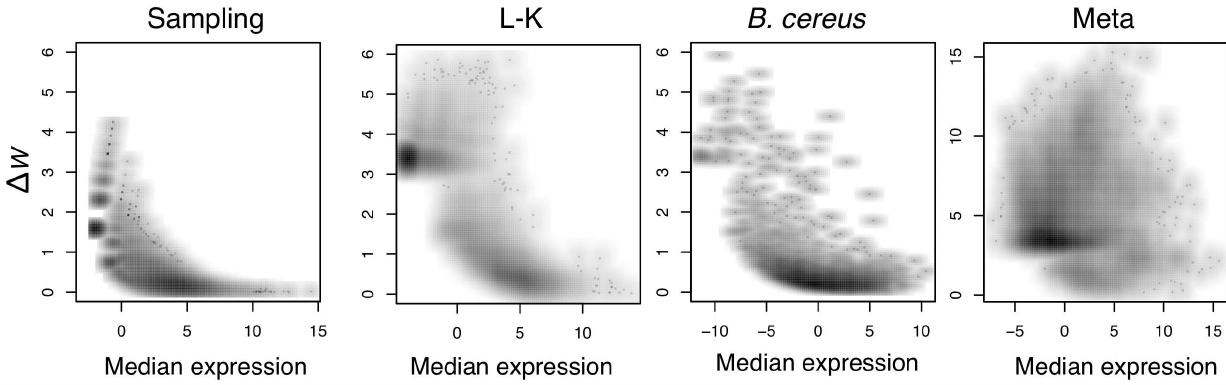
Figure 2. Sampling and technical variance is distinct from within-condition variance. A comparison of within-condition gene expression- difference to the median expression level for three different experiments. The left panel shows the sampling variance for comparison and the three experiments are shown in subsequent panels. The L-K RNA-Seq data set compares gene expression in two liver and two kidney samples. The Bacillus cereus RNA-Seq data set for samples grown at neutral pH and two samples 20 minutes after shift to grown at low pH. Meta-RNA-Seq data is for microbial gene expression analysis of four clinical vaginal samples from two women with a healthy microbiota and two women with a microbiota indicative of bacterial vaginosis. The RNA-Seq experiments in the L-K and B. cereus datasets were from controlled conditions with identical gene content per condition and show that the vast majority of highly-expressed genes have small within-condition estimates of q i , and that estimate only becomes imprecise as q i becomes very small. The Meta-RNA-Seq panel shows that when within-condition variance is high, there is no relationship between the expression level and the within-condition variance. Note that base-2 logarithms were used throughout.